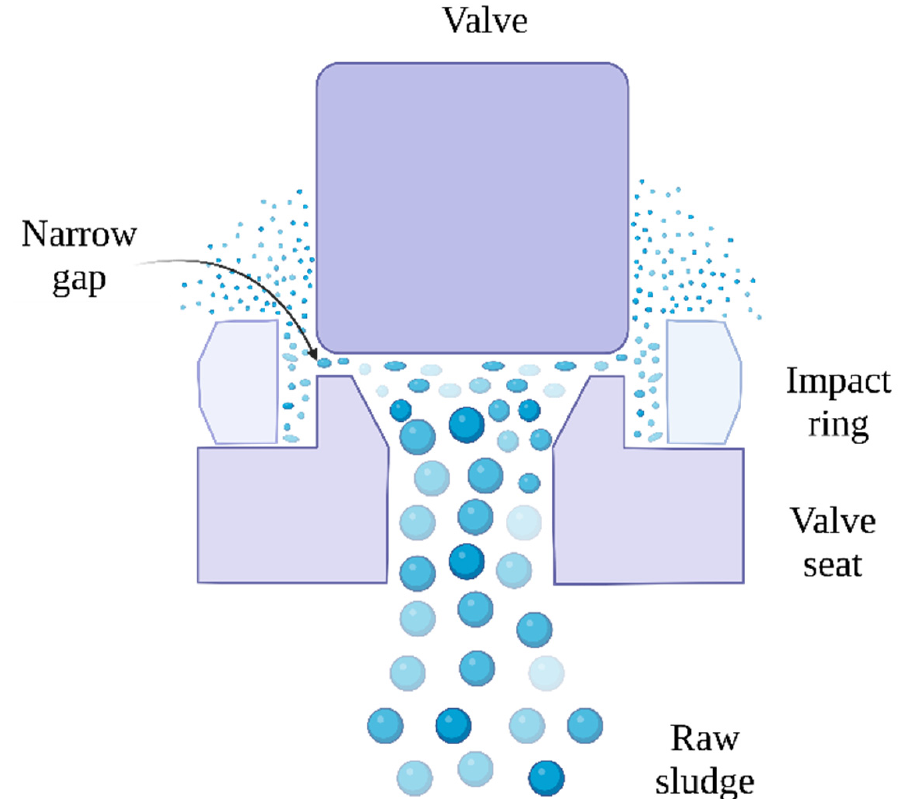
Figure 7. Typical high-pressure homogenization schematic configuration.